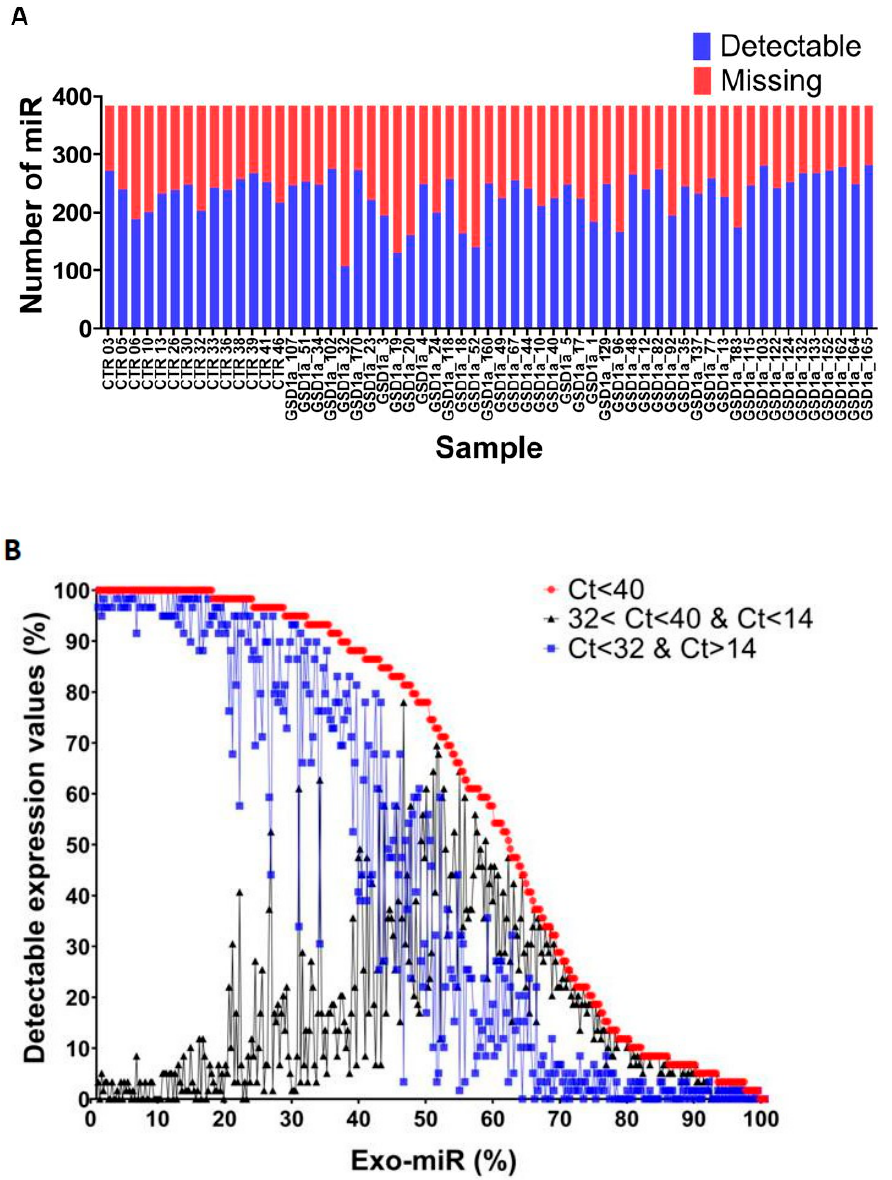
Figure 2. Quality assessment of Exo-miR expression profiles. The plots in panels ( A ) and ( B ) show the distribution of detectable and missing Ct values across samples. Panel ( A ) shows a stacked column chart for visualizing the proportion of detectable (blue column) and missing (red stacked column) Ct values across the samples. Sample identifiers are shown on the x axis. The number of microRNAs is shown on the y axis. Panel ( B ) shows the percentages of Exo-miRs and Ct detectable values for three levels of reliability of the Ct values. Reliable and unreliable Ct values are colored in red. Reliable Ct values are colored in blue. Unreliable Ct values are colored in black. Curves are sorted in decreasing order of the percentage of miRNAs with Ct < 40 values. The legend is displayed in the top-right part of the